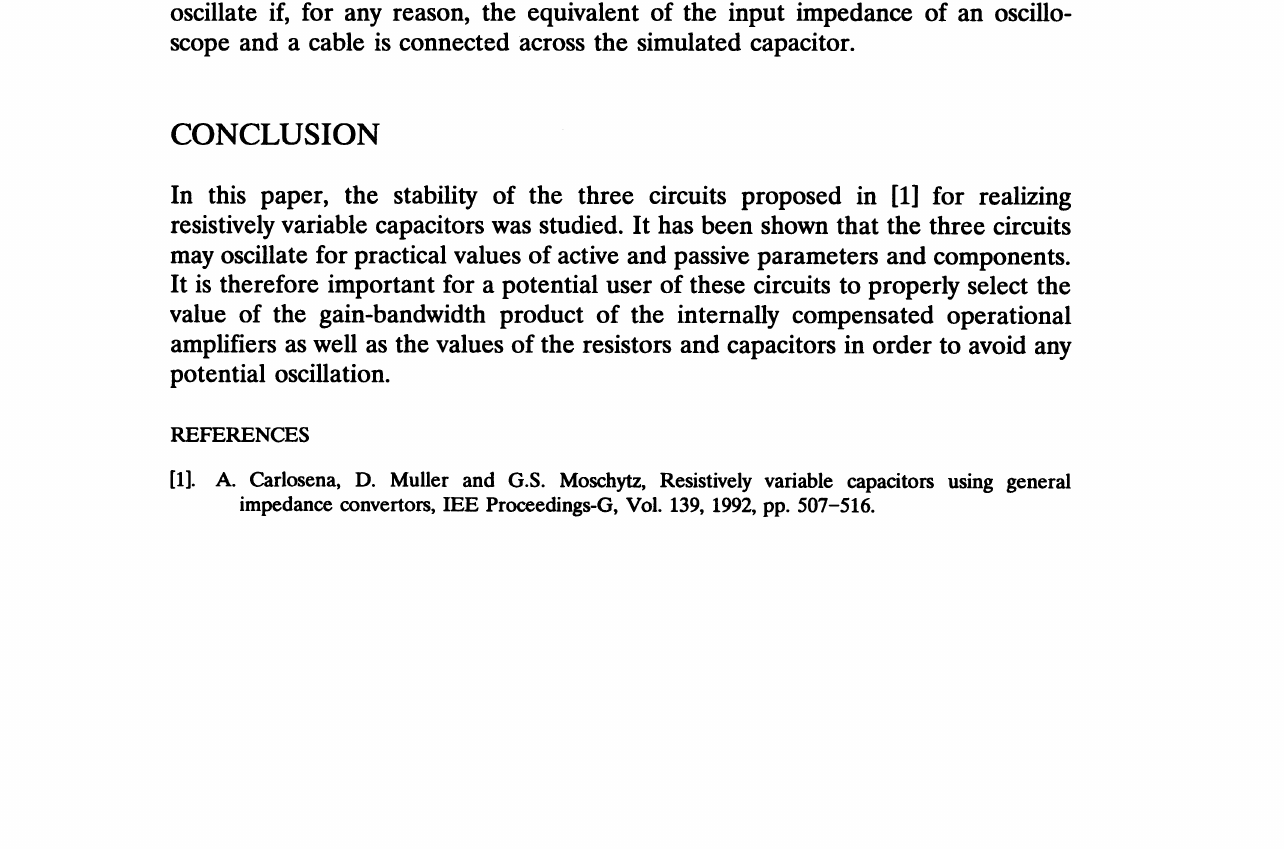
FIGURE 4 Experimental results obtained from Fig. l(c)with: R 100 K R 1 M, frequency 8.5 KHz, Vp_p 7.2 V. Operational Amplifiers: CA741CE.